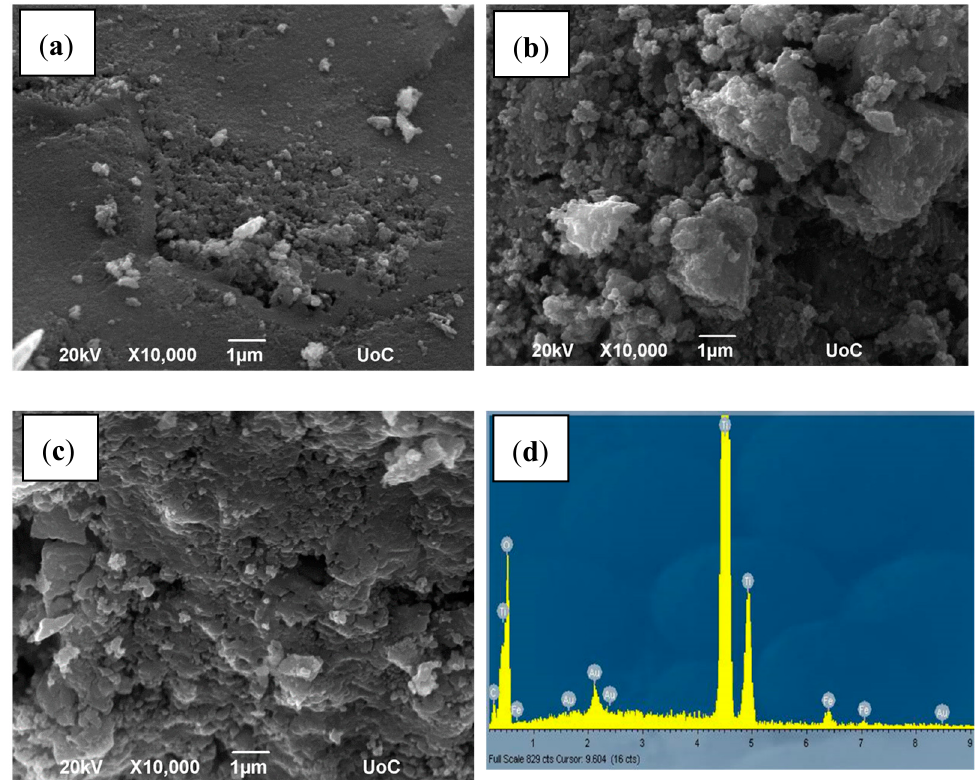
Figure 3. SEM images of doped samples (( a ): 0.04%; ( b ): 0.3%; ( c ): 2%) and EDS spectrum of the 2% sample ( d ).